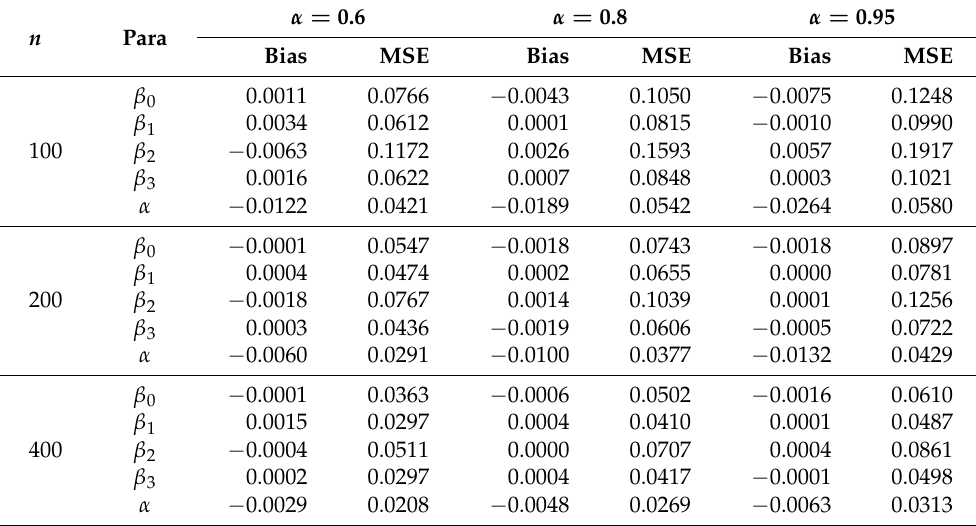
Table 2. Parameter estimates based on 10,000 replications for Case